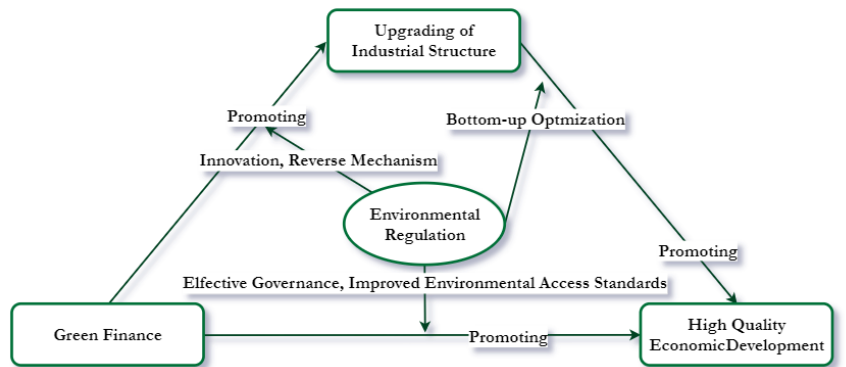
Figure 2. Mechanism of the regulatory role of environmental regulation.